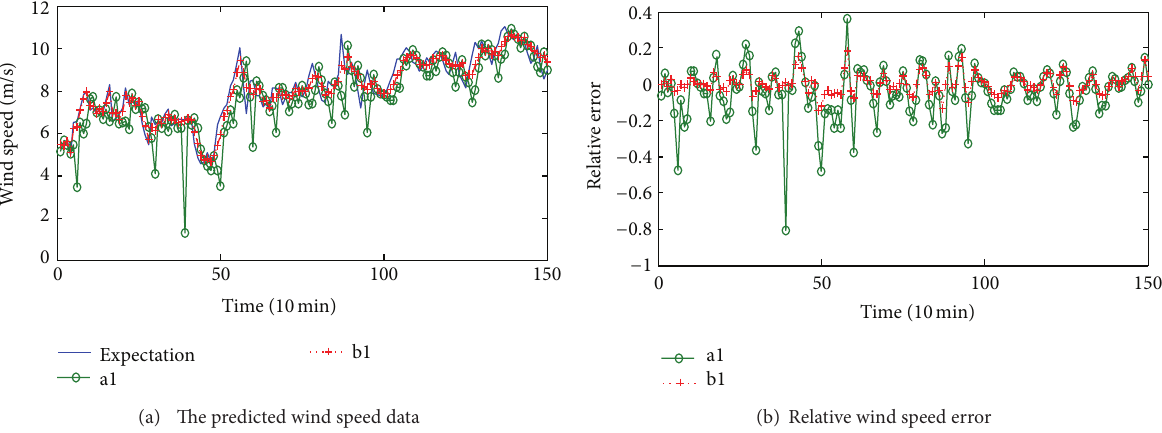
Figure 1: The effect comparison between a1 and b1.